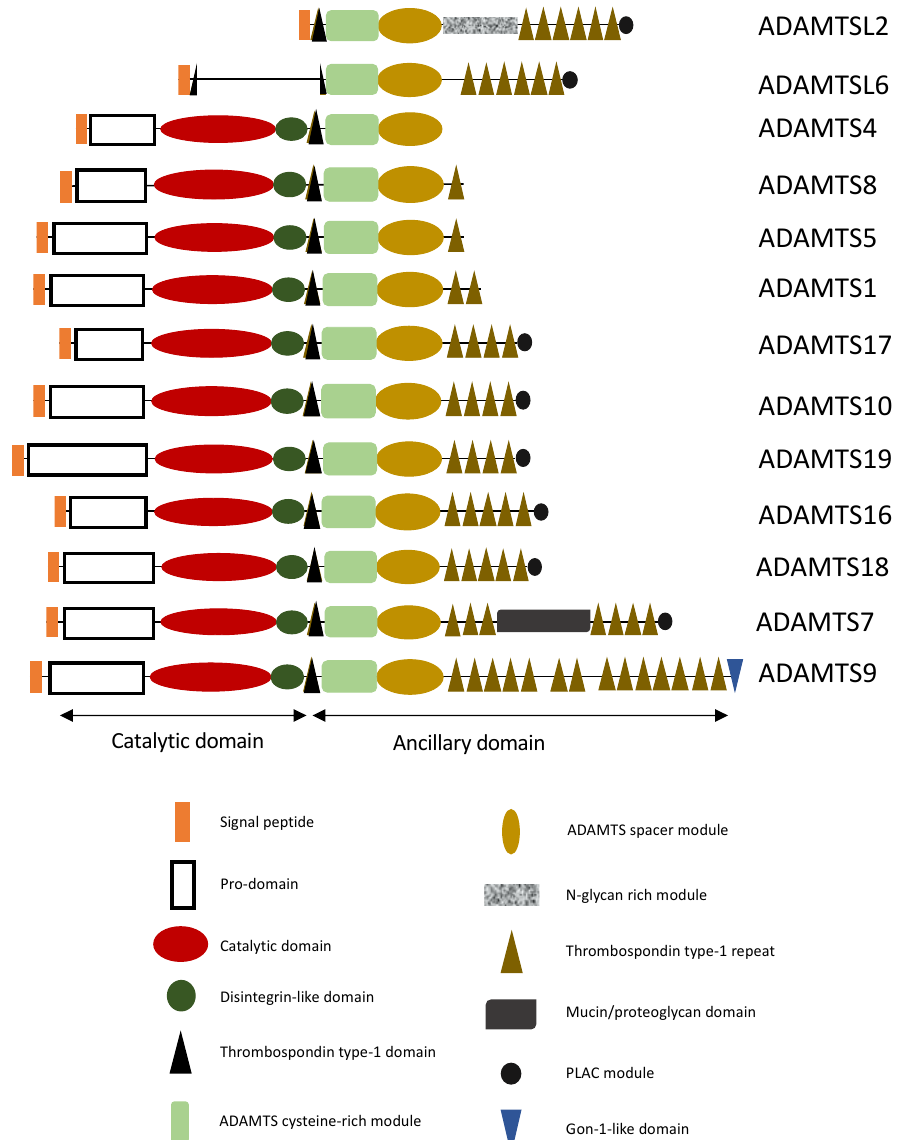
Figure 1. Structural representation of ADAMTS(-L) involved in aortic aneurysms. ADAMTS have a characteristic domain organization consisting of a catalytic domain at their N-terminus, and a C-terminal ancillary domain (Figure 1). The ancillary domain has a modular organization containing distinct modules, such as an ADAMTS cysteine-rich module, an ADAMTS spacer module, thrombospondin type-1 domains and the presence or absence of PLAC module and/or mucin/proteoglycan domain (see Figure).